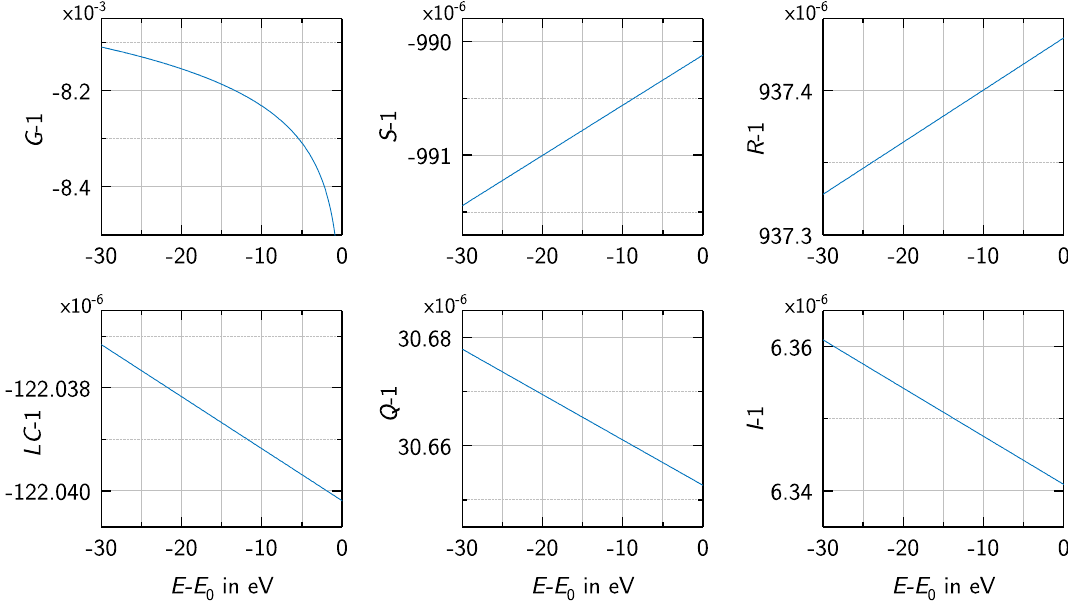
Fig. 5 Theoretical correction factors to the differential β -decay spectrum of T 2 , evaluated in an interval 30eV below the endpoint E 0 and summed over possible final states